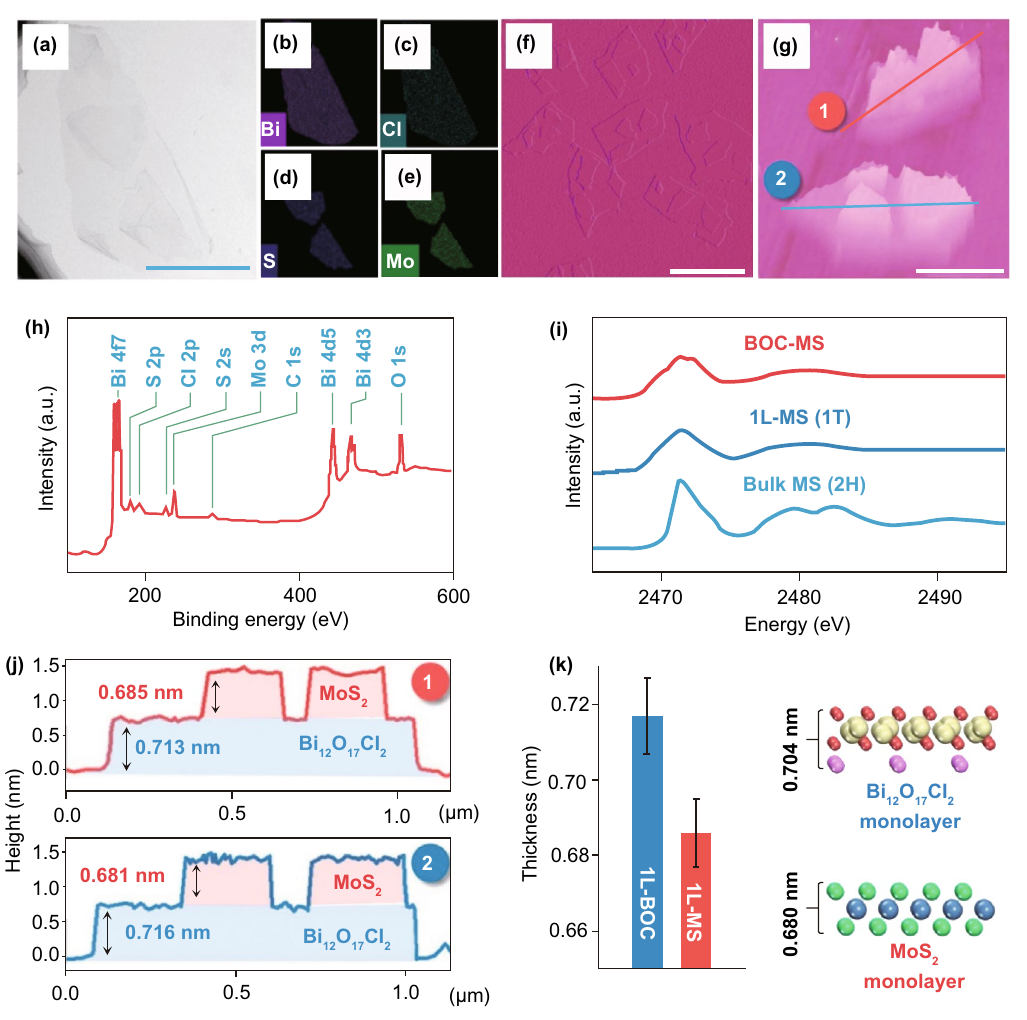
Fig. 16 a TEM top view analysis. b–e elemental mapping images, f XPS spectrum. h , i AFM analysis. m TEM images side view. n Atomic resolution HAADF‑STEM image. o–s Respective EELS elemental maps of BOC‑MS. g S K‑edge XANES spectrum of BOC‑MS, 1L‑MS, and bulk MS. j Height profiles along lines in i . k Comparison of 1L‑BOC and 1L‑MS in BOC‑MS average thicknesses. Error bars in ( k ) show s.d. over 100 self‑sufficient AFM calculations. SLs